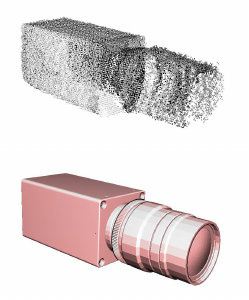
Figure 8. Segmented point cloud exemple of an industrial camera from TLS acquisitions (top) and the corresponding CAD constructor model